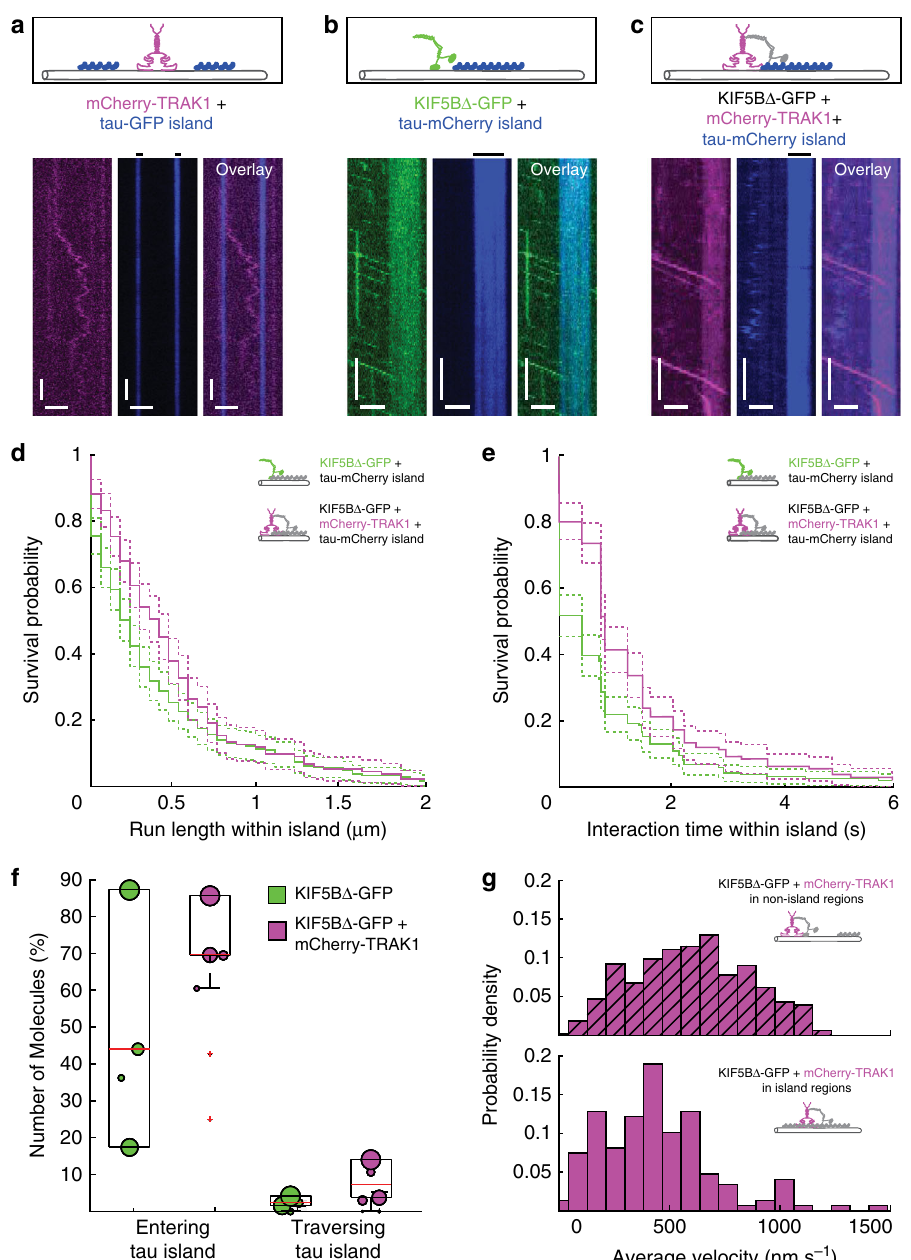
Fig. 3 TRAK1 promotes KIF5B processivity in cohesive tau islands. Schematic illustrations and kymographs of a mCherry-TRAK1 (magenta) diffusing in non-tau island regions but not entering tau-GFP islands (blue), b processive movement of KIF5B Δ -GFP (green) dissociating at the edges of tau-mCherry islands (blue) and c KIF5B Δ -GFP in presence of mCherry-TRAK1 (magenta) penetrating into tau-mCherry islands (blue). The positions of the tau-mCherry islands are denoted by black horizontal lines. Horizontal scale bars 1 µ m, vertical 5 s. The experiments were repeated 4 times independently with similar results d , e Survival probability plots showing the increased median run length and interaction time of KIF5B Δ -GFP within tau-mCherry islands in presence of mCherry-TRAK1 (magenta) in comparison to KIF5B Δ -GFP in absence of mCherry-TRAK1 (green) ( p = 0.0141 and p < 10 − 4 , respectively). Two-tailed p - values were obtained by a log-rank test. f KIF5B Δ -GFP in presence of mCherry-TRAK1 (magenta, n = 202 molecules, N = 6 experiments) showed a higher probability to enter and traverse tau-mCherry islands than KIF5B Δ -GFP alone (green, n = 240 molecules, N = 4 experiments). Red lines present the median values, top and bottom edges of the black boxes present upper and lower quantiles, whiskers present the highest/lowest data points and red crosses present outliers. Data points are weighted by the number of measurements. For island length distributions see Supplementary Fig. 3. g Histograms showing the average velocity of KIF5B Δ -GFP-mCherry-TRAK1 complexes in non-island regions (magenta dashed, same dataset as in Fig. 2f) and within tau-mCherry islands (magenta, n = 148 molecules, N = 6 experiments). Source data are provided as a Source data fi